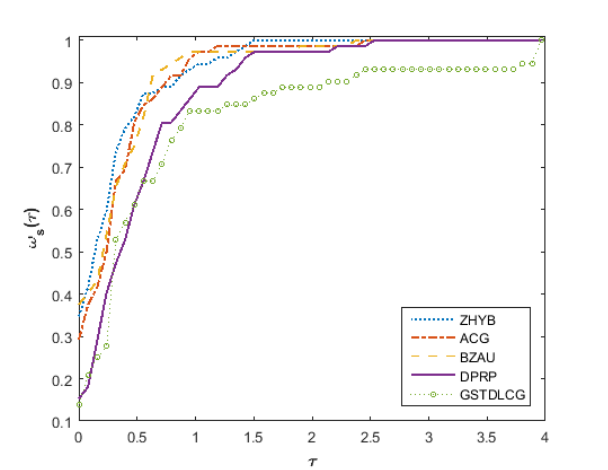
Figure 1: Number of iterations performance profiles